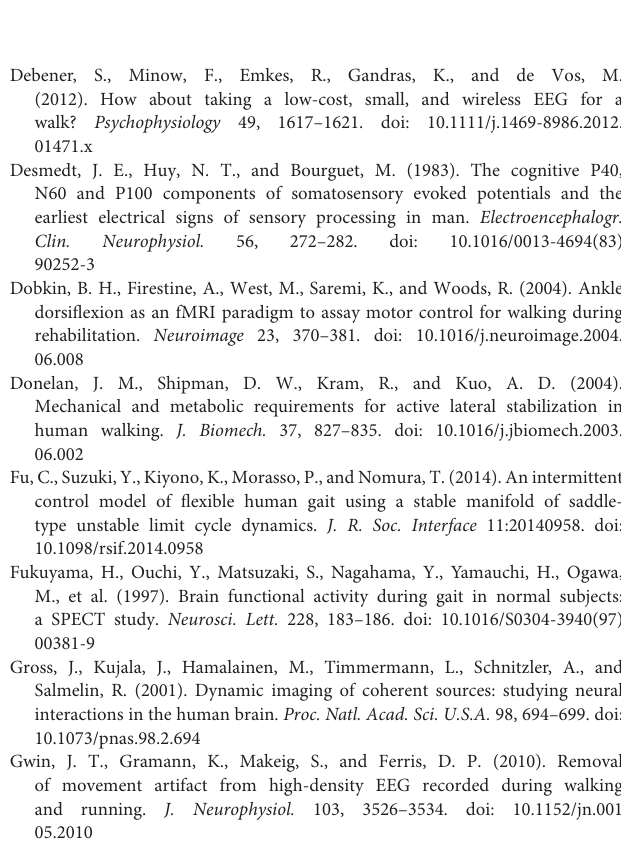
Supplementary Figure 1 | DICS beamformer results for the contrast walking vs. stabilized walking at 18Hz. Color intensity indicates t -values. Supplementary Figure 2 | DICS beamformer results for the contrast stabilized walking vs. sitting at 18Hz. Color intensity indicates t -values. Figure is tresholded at |t| > 4.5. Supplementary Figure 3 | Source localization (MUSIC) results for the SEP condition during sitting, without cleaning. Supplementary Figure 4 | Source localization (MUSIC) results for the SEP condition during walking, without cleaning. Supplementary Figure 5 | Source localization (MUSIC) results for the SEP condition during sitting, after cleaning. Supplementary Figure 6 | Source localization (MUSIC) results for the SEP condition during walking, after cleaning. Supplementary Figure 7 | Individual sources. The green and blue circle represent the group peak t -values, the stars represent the individual subject sources used for analysis. Supplementary Figure 8 | Figure 9 with results for right premotor area at 17Hz also